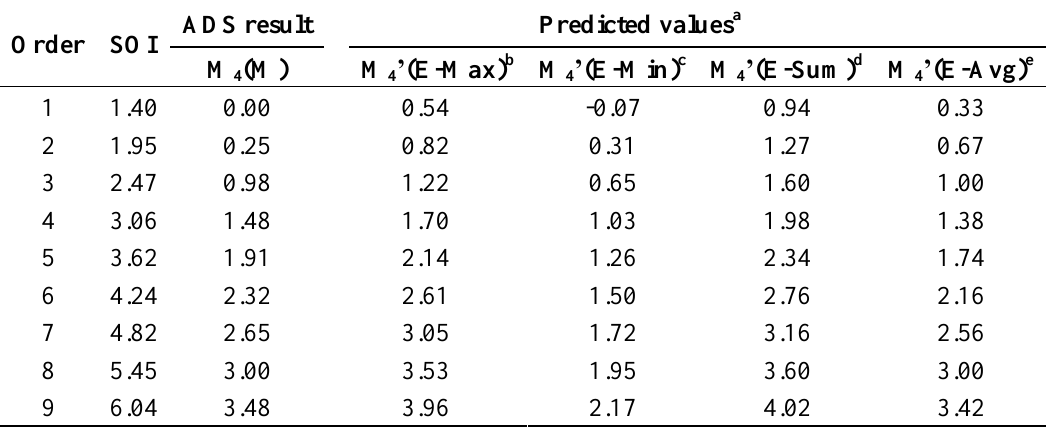
Table 4. Comparison of various log (D/T) ratios between measured (M predicted values (M ‟) at each of all corresponding SOI 4